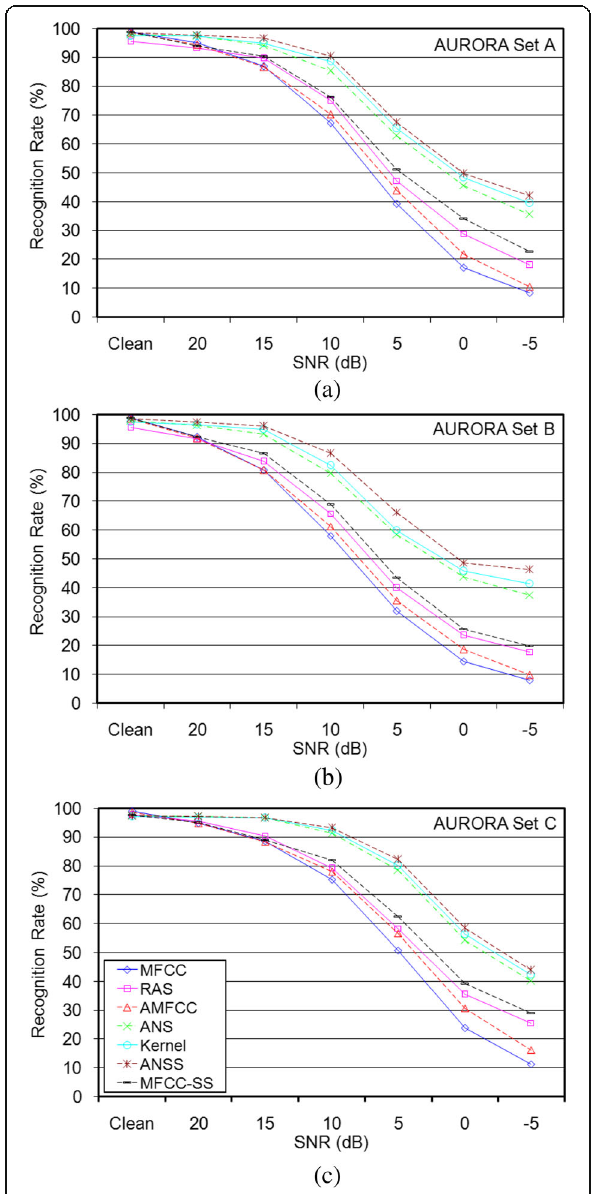
Fig. 9 Average recognition rates of MFCC, RAS, AMFCC, ANS, kernel, ANSS, and MFCC-SS on Aurora 2 task. a Test set A, b Test set B. c Test set C